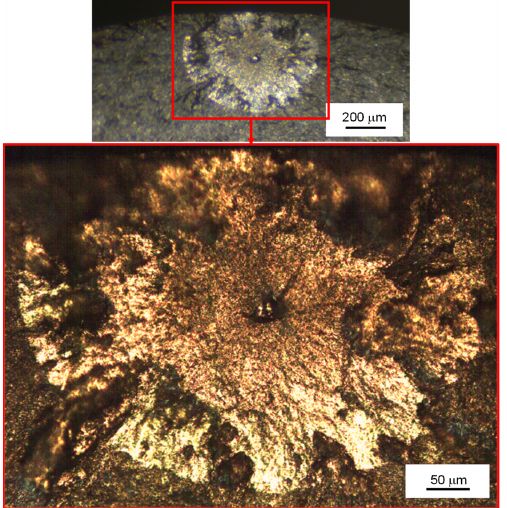
Figure 10. Crack initiation site in a sample of Set HMP-D.